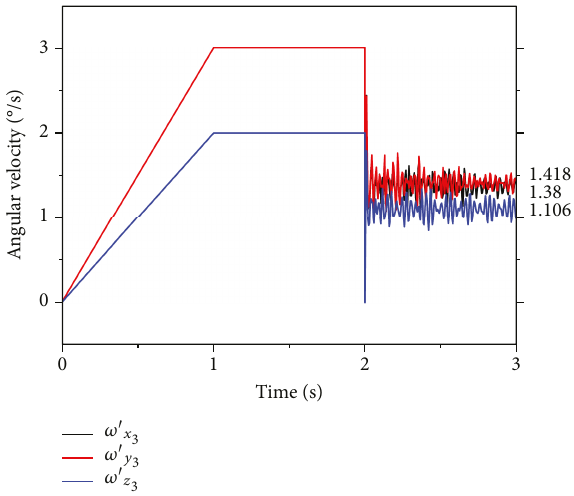
Figure 17: Simulation results of empty storage tank and microsatellite for ω x